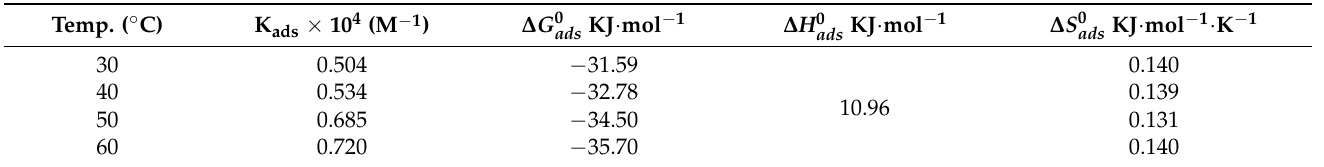
Table 3. Thermodynamic adsorption parameters in 1 M HCl for MS at various CMEA doses between 30 and 60 ◦